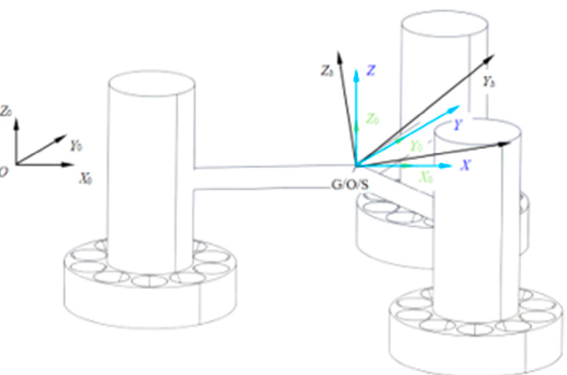
Figure 6. Coordinate system of the three-floating-body wind turbine platform.